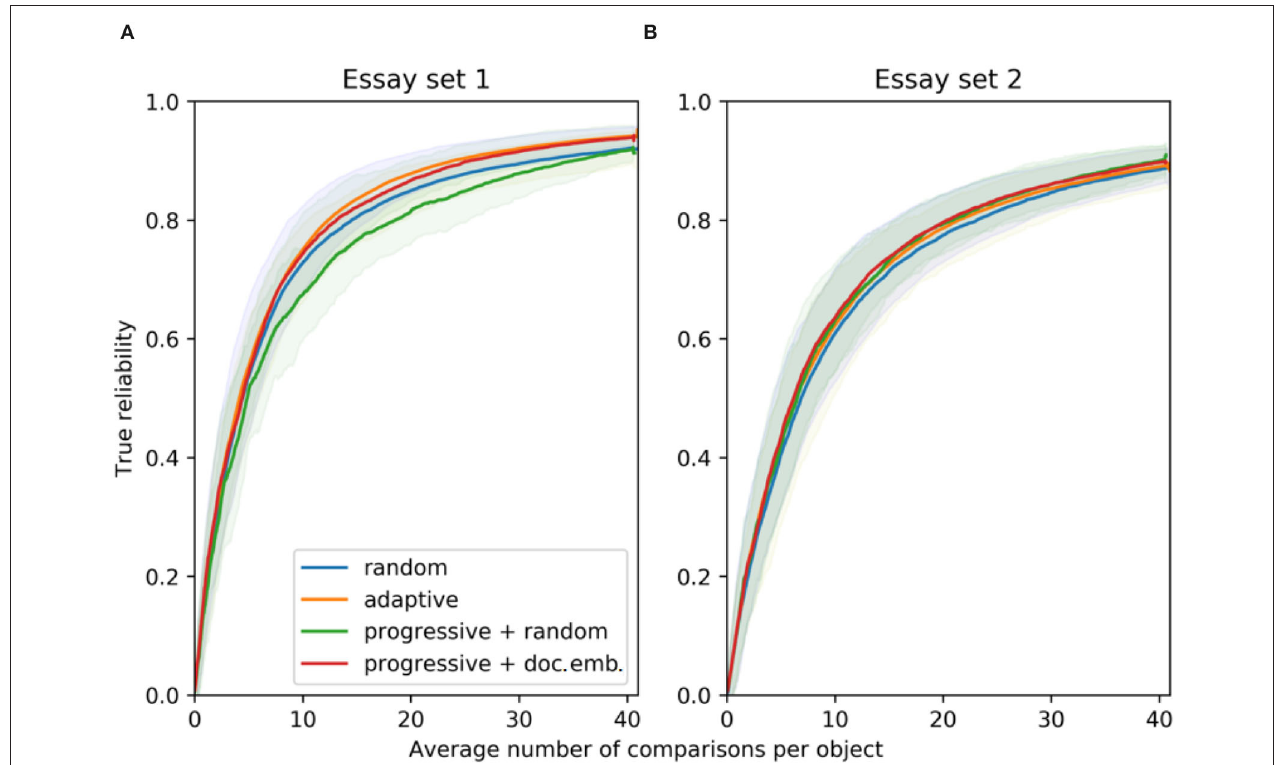
FIGURE 3 | For essay set 1 ( A , N 1 = 141) and 2 ( B , N 2 = 150), the true reliability resulting from the selection rules: for random (CJ), adaptive (ACJ), and a progressive selection with a random and a similarity component using document embeddings of essays (100 simulations). The solid lines indicate the mean values and the transparent bands indicate the 95% point-wise confidence